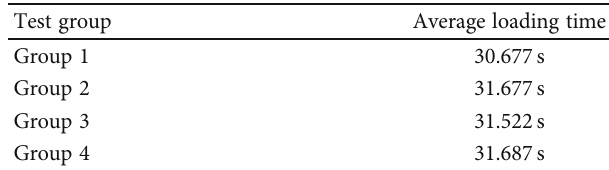
Table 3: Test of count statement of statistical query function.